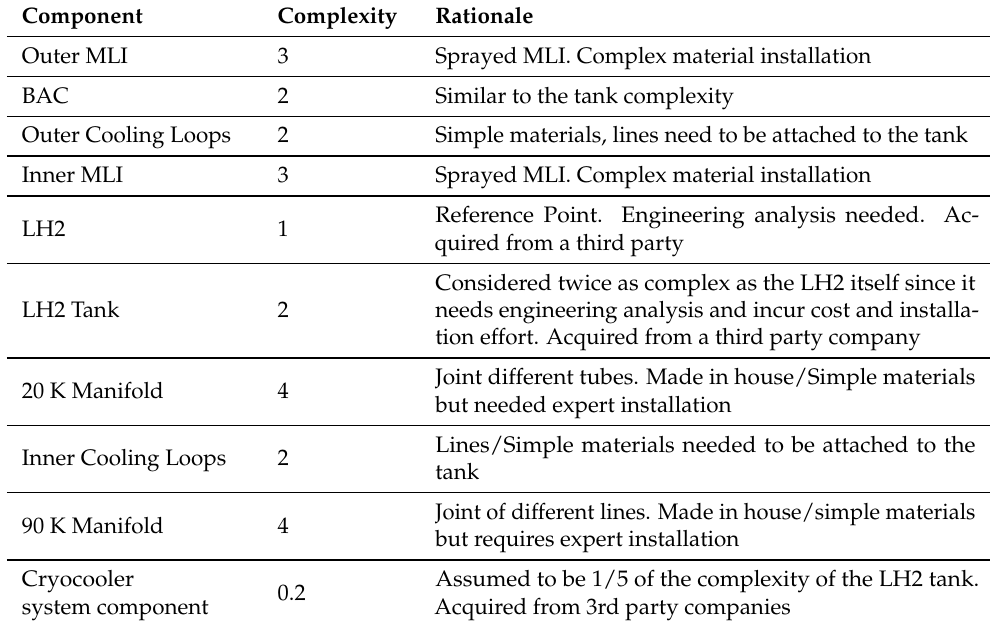
Table 5. Component complexity values α i and rationales.